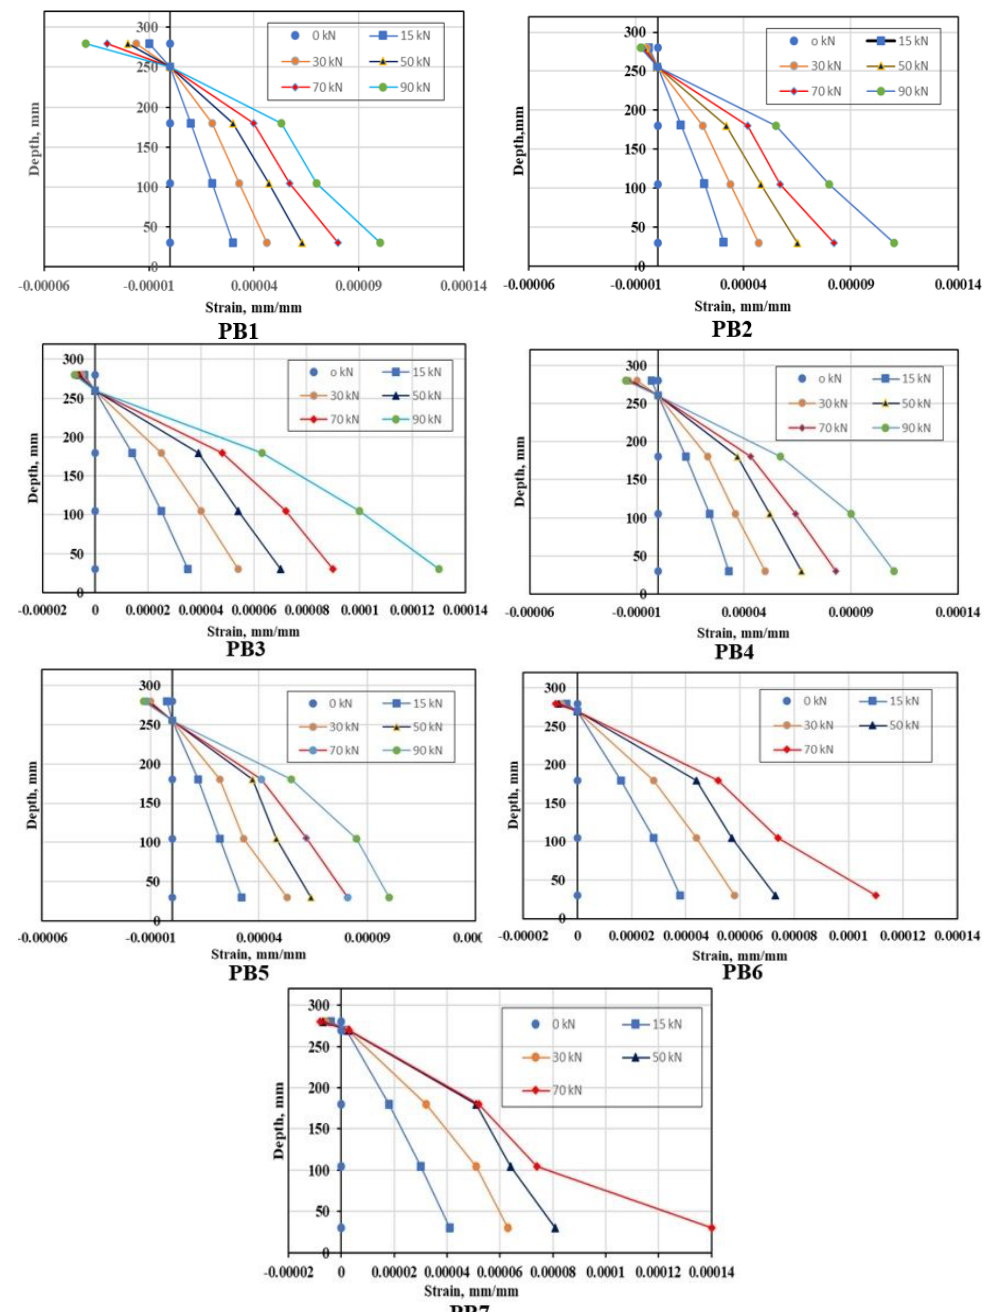
Figure 11: Concrete strains of tested composite beam specimens